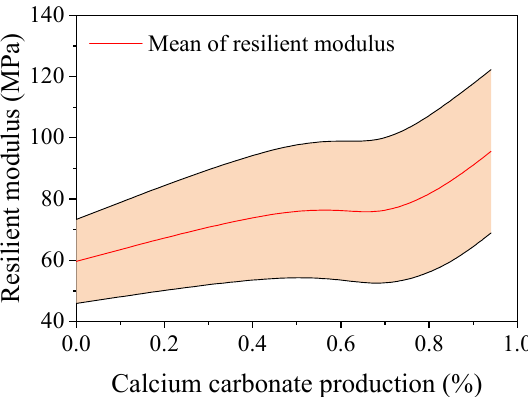
Figure 10. Dynamic resilient modulus with different CaCO 3 production.